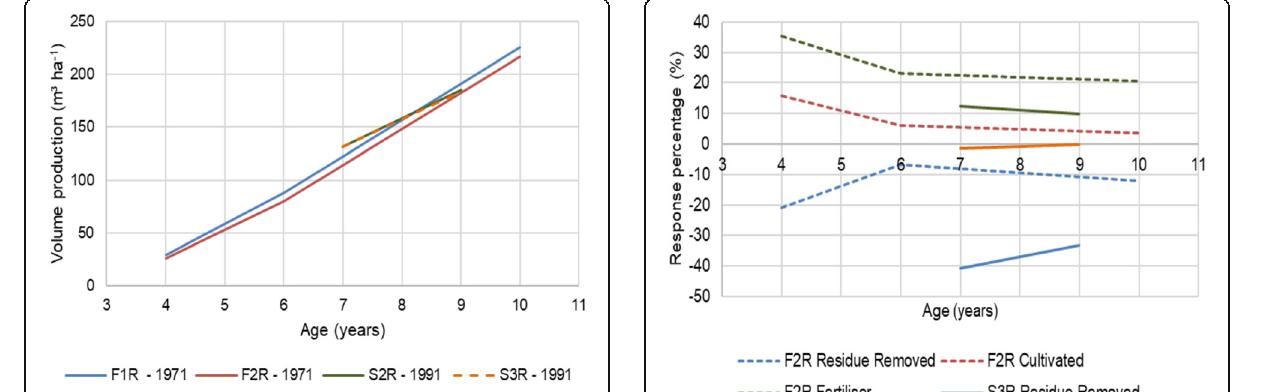
Fig. 2 Mean volume increment across all treatments over the three sites (A9, C9, D5) in the first (F1R) and second rotation (F2R) areas established in 1971, and the second (S2R) and third rotation (S3R) areas established in 1991